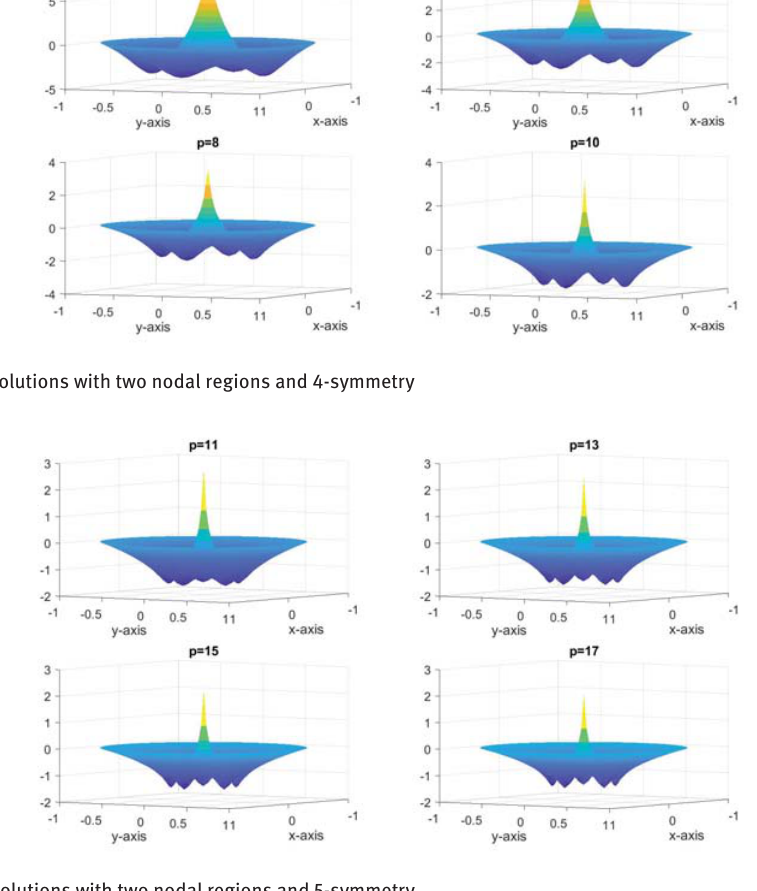
Fig. 6: Numerical solutions with two nodal regions and 5-symmetry